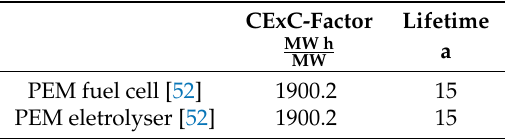
Table A1. CExC-factors and lifetime for PEM fuel cell and electrolyser.